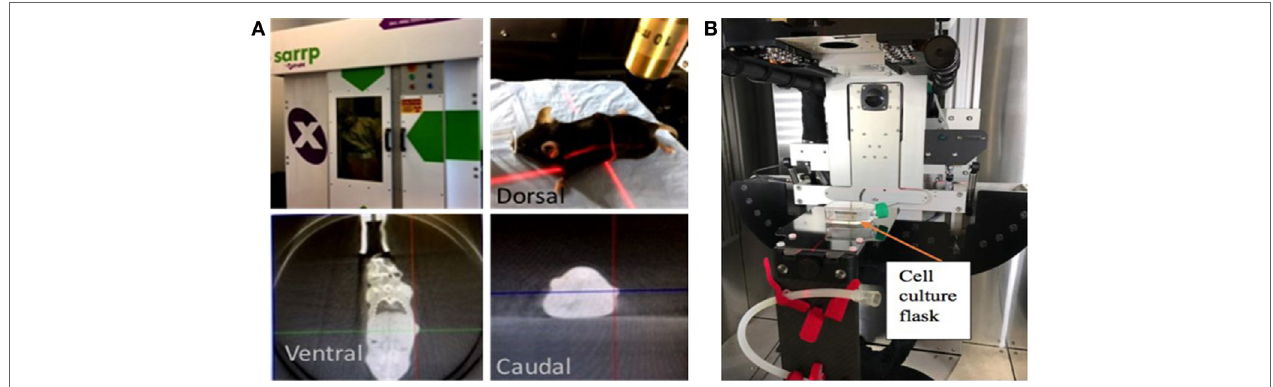
FigUre 1 | Small animal radiation research platform (SARRP). Showing pictures of set-up for (a) image-guided radiotherapy (RT) with computed tomography imaging done using 65 kVp photons at 0.5 mA, (B) in vitro studies with RT delivered using 220 kVp photons and 13